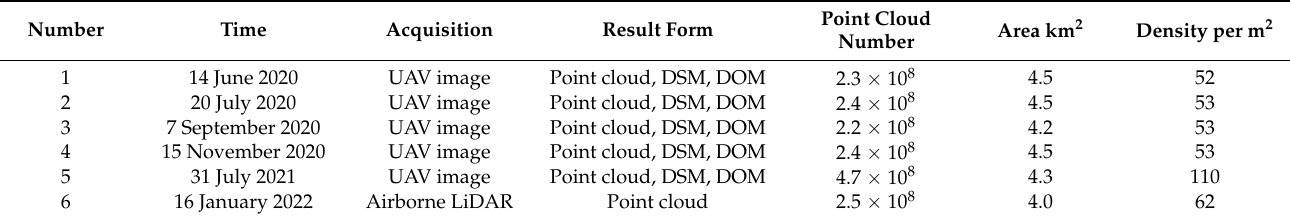
Table 1. Time series data collection statistics.